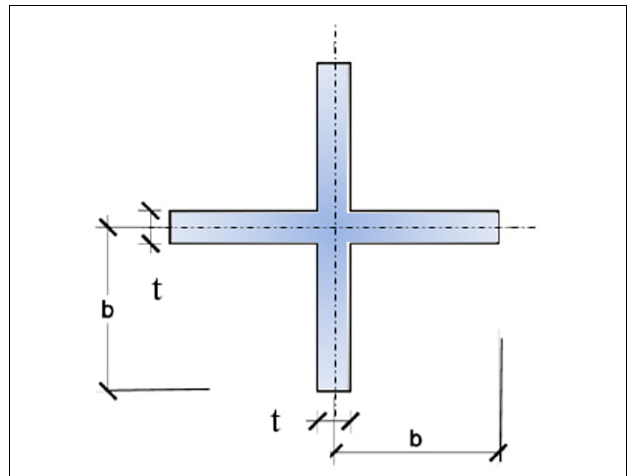
TABLE 1 | The dimensions and the aluminium alloy materials of the specimens.